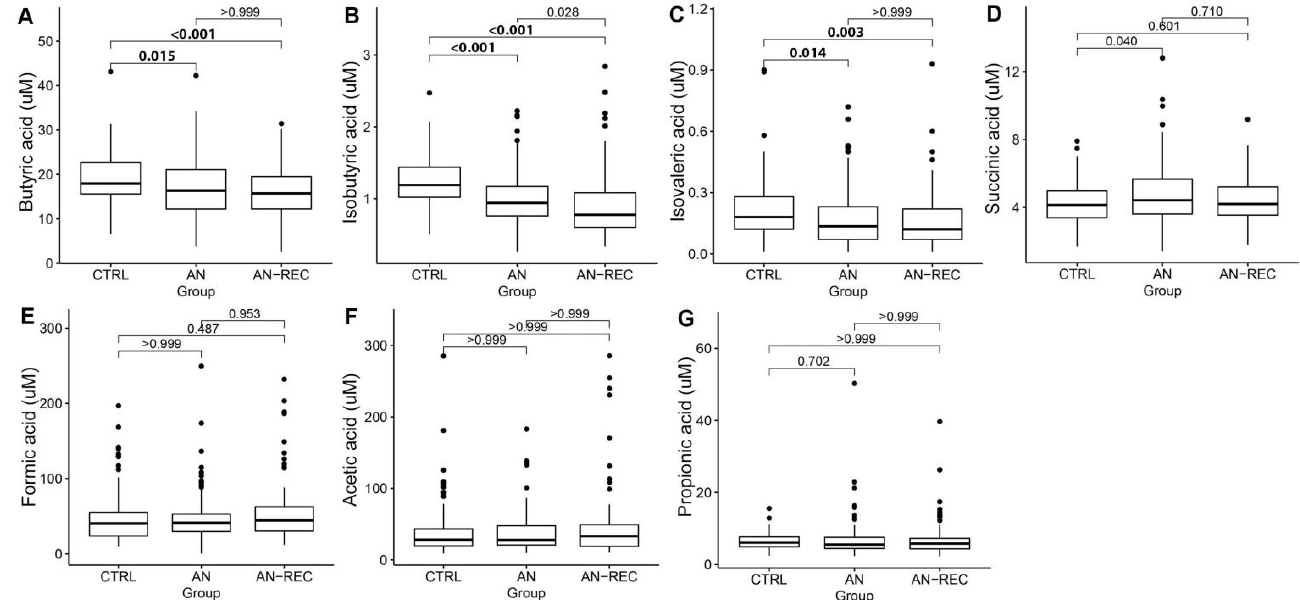
Figure 1. Box plots illustrate group differences in adjusted plasma concentrations of SCFA; butyric- ( A ), isobutyric-( B ), isovaleric-( C ), succinic-( D ), formic-( E ), acetic-( F ) and propionic acid ( G ), in active anorexia nervosa (AN), recovered AN (AN-REC), and normal-weight controls (CTRL). The median is shown as a straight line and the box denotes the interquartile range. p < 0.017 is considered significant.